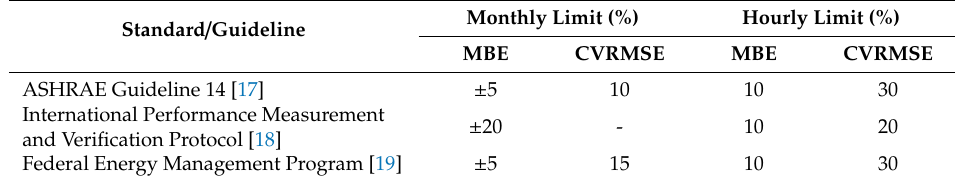
Table 1. Limits of MBE and CVRMSE for the calibration of building simulation models defined by di ff erent standard /